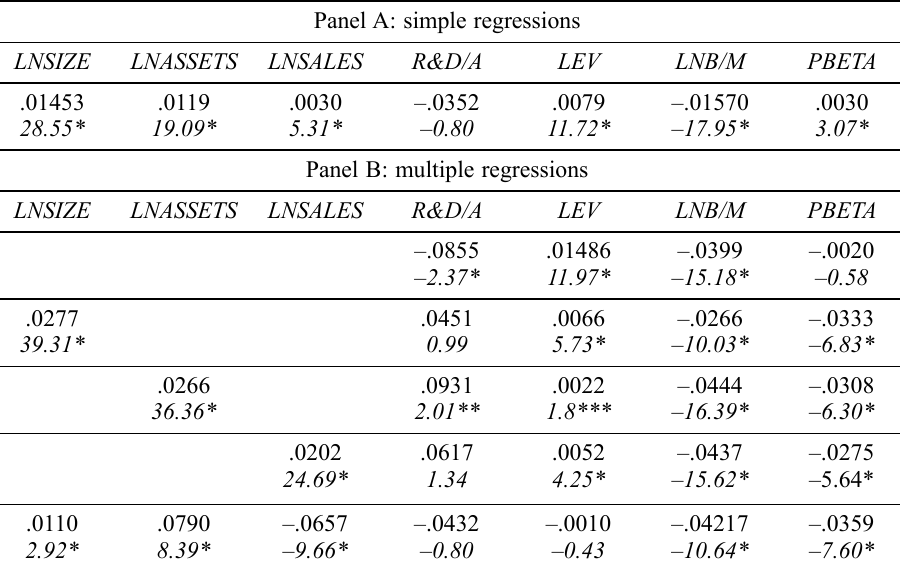
on industry average